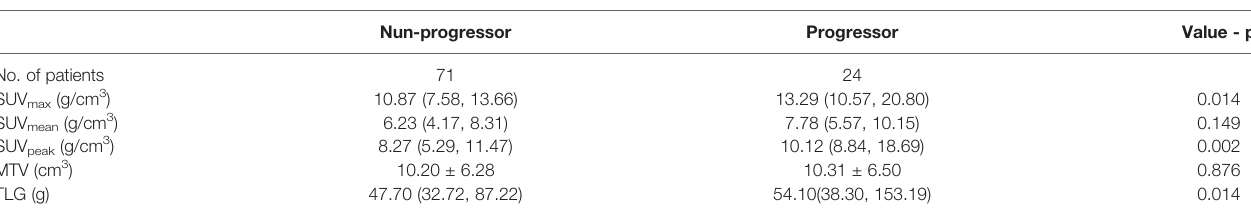
TABLE 2 | Patients ’ PET/CT